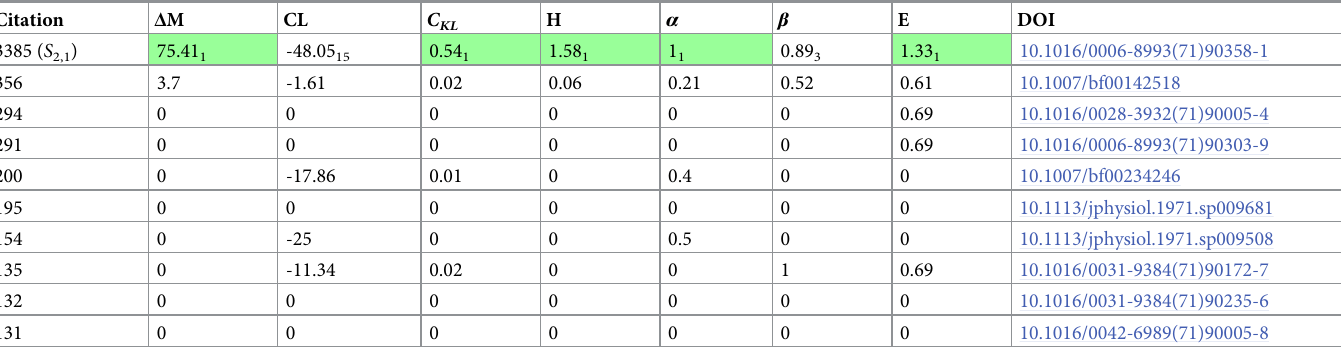
Table 5. Case 2. The SVA scores of top-10 most cited papers in the network (1966-1971). SVA score ranges: Δ M :0.0–75.41, CL :-48.05–0.00, C KL :0.0–0.54, H :0.0–1.58, α :0.0–1.0, β :0.0–1.0, E : 0.0–1.3. The subscript next to an SVA score of each seed paper indicates the paper’s relative rank according to that metric, sorted in a descending order.